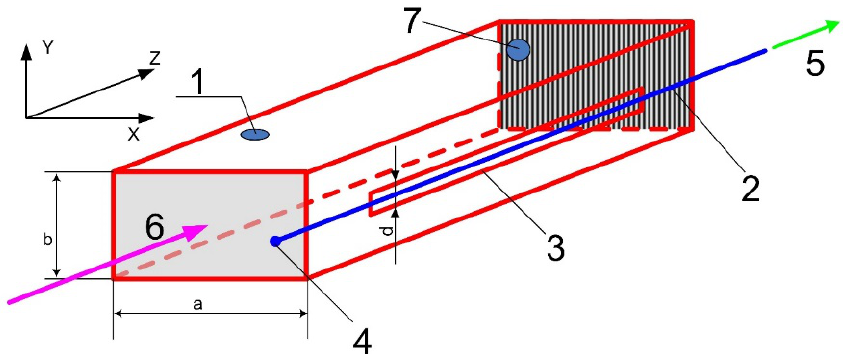
Figure 1. Scheme of the experiment. 1—section of a rectangular microwave waveguide, a = 9 cm, b = 4.5 cm, 2—optical HCF, 3—longitudinal slot in the side wall of the waveguide, 4—sealed end of the HCF, 5—connection of the HCF to the vacuum and the gas filling systems, 6—the direction of electromagnetic wave propagation along the waveguide from the magnetron, 7—a waveguide sliding short that reflects microwave radiation back and thus forms a standing wave.